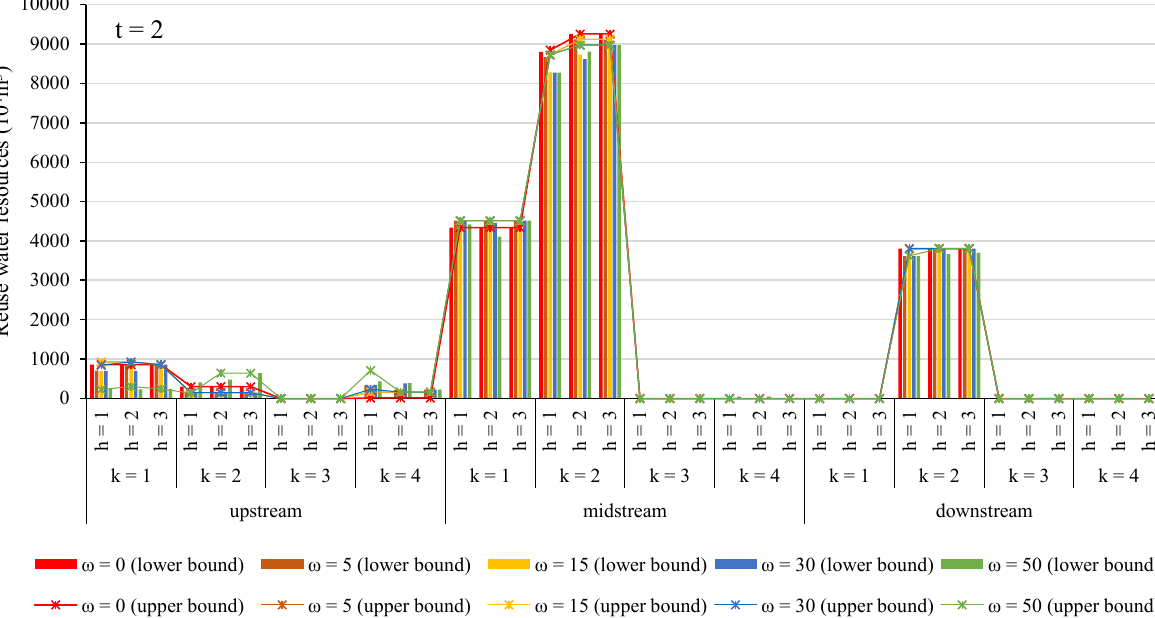
Figure 13. Reused water resources for by region in the Fenhe River Basin in period 3. 4.3. Policy Interventions and Analysis This study demonstrates that water resources are insufficient to support regional so- cio-economic development and to ensure environmental quality in the Fenhe River Basin; furthermore, reused water is a key factor for addressing the water shortages. To reflect optimal regulation under severe water shortage conditions, we consider an ω value of 15 and low water resource level (h = 1) as the baseline scenario (S1). In another policy scenario, S2, the water reuse rate gradually increases to at least 0.4, in period 3.